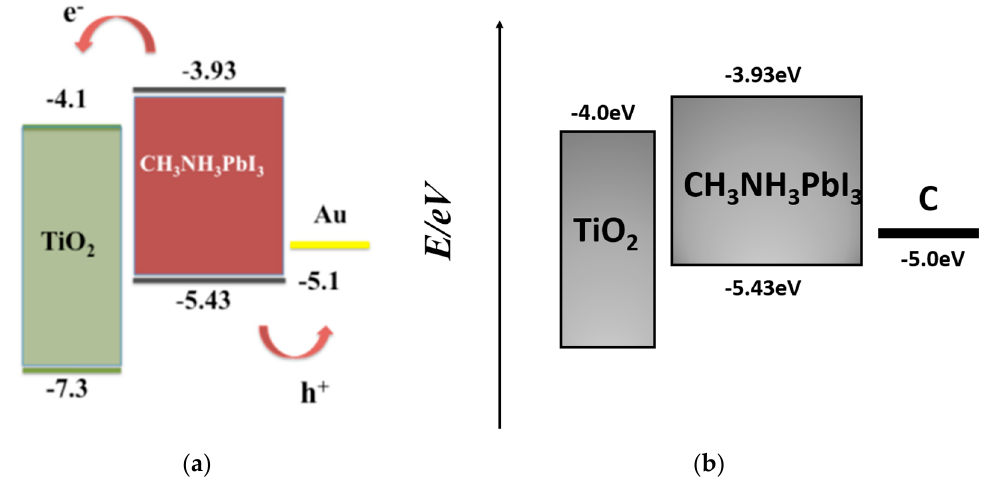
Figure 11. Band alignment of hole-conductor-free device-based ( a ) Au electrode [117] and ( b ) C